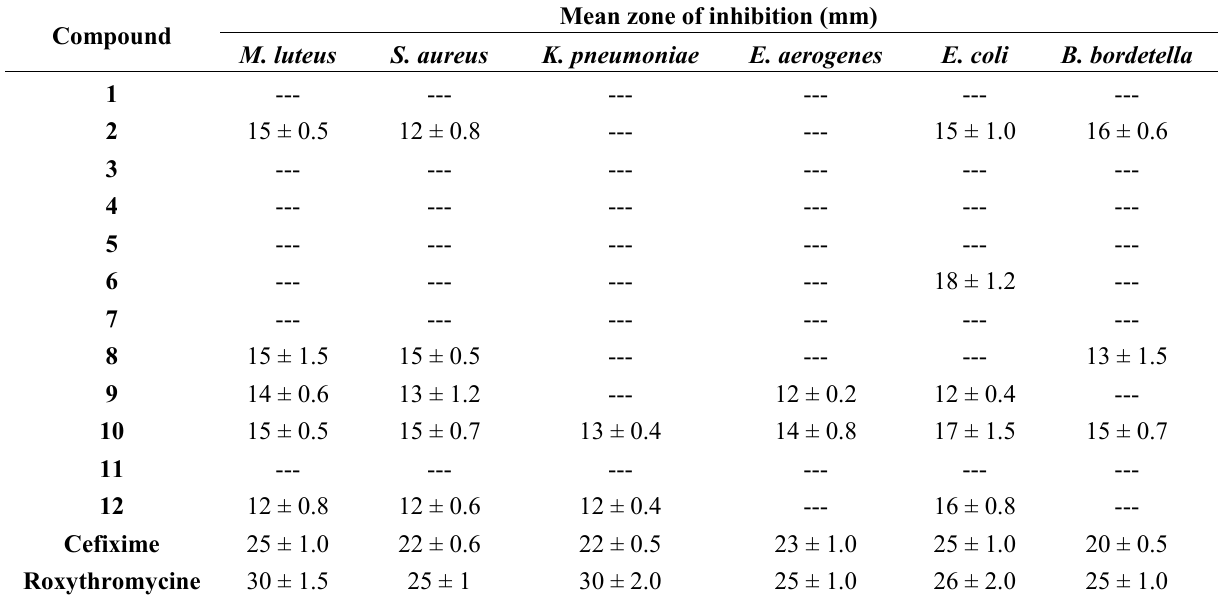
Table 6. In vitro antibacterial activity (mean zone of inhibition) of synthesized guanidines and standard drugs.